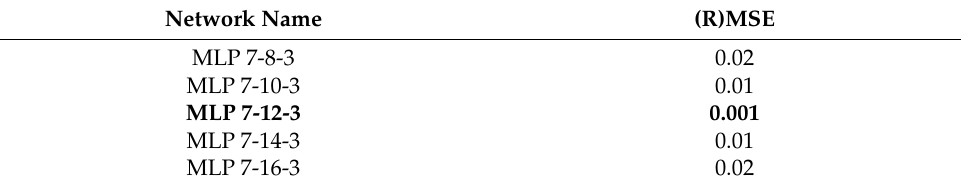
Table 5. (R)MSE values for three MLP neural networks (the best one is marked in